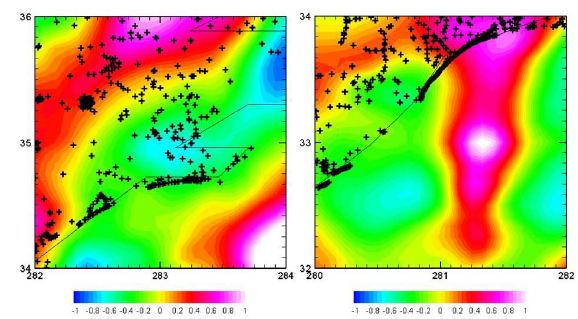
Figure 5. Omission error in terms of geoid height estimated from EGM2008 from degree and order 181 to 2190 in [m] and distribution of GPS-Levelling points in the area. Left: Block at USA East coast in North Carolina (Latitude 34 ◦ N to 36 ◦ N, Longitude 282 ◦ W to 284 ◦ W) with 391 GPS-Levelling points. Right: Block at USA East coast in South Carolina (Latitude 32 ◦ N to 34 ◦ N, Longitude 280 ◦ W to 282 ◦ W) with 475 GPS-Levelling points. Black line indicates the approx- imate